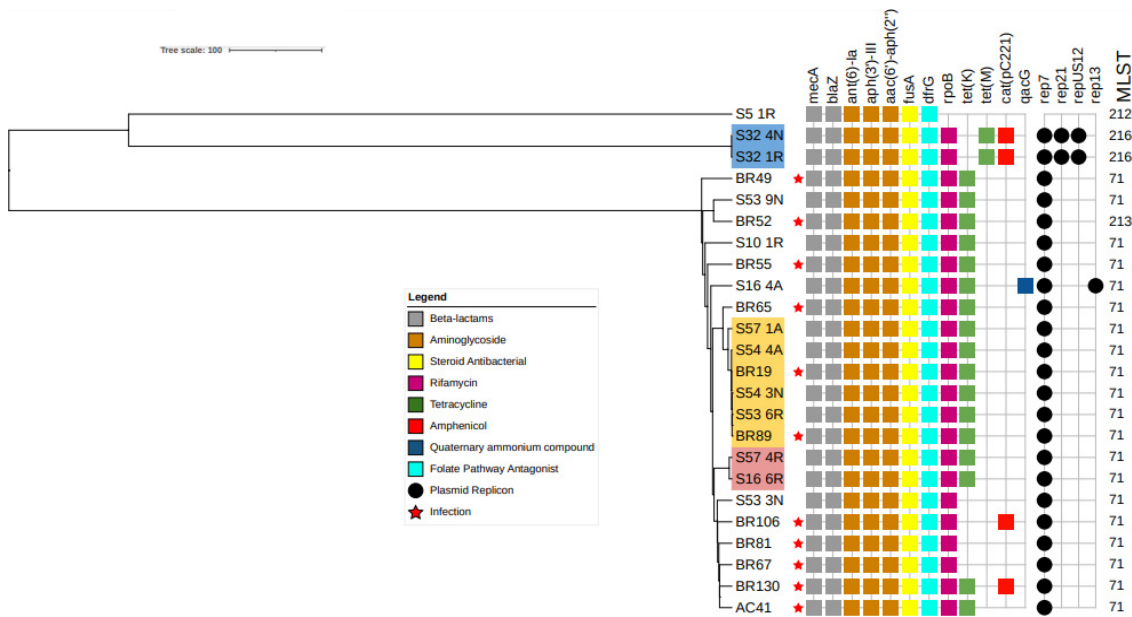
Figure 3. Genetic relationship between MRSP strains isolated from dogs admitted to the ICU of HV-UFMG and Staphylococcus spp. infected dogs attended at HV-UFMG [15], between 2018 and 2019. Each isolate was subjected to single nucleotide polimorphism (SNP) analysis using CSIPhylogeny [16] with S. pseudintermedius strain DG072 (accession number GCA_016455165.1) as a reference. A minimal Z-score of 1.96 and a minimal depth at SNP position of 10× were used. The percentage of reference genomes covered by all isolates was 81.1%. The tree image was generated using iTOL [17] online using midpoint rooting.